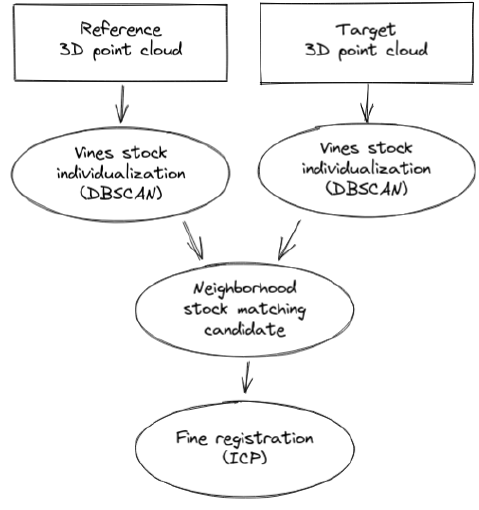
Figure 10: Details of the 3D non rigid registration method. The data from the same row of vines were selected from both the reference and the target datasets, then processed separately to re- construct each vine in 3D (Figure 12-Top): 201957 points and 16 clusters have been extracted from the target dataset, respectively 183401 points and 18 clusters from the reference dataset (Fig- ure 12-Center). This difference in the number of stocks detected has two explanations: one of the two acquisitions covers a slightly larger area, and with the leaves some vines can be grouped by two, without impacting the results presented below. Thus, a fine and precise 3D reconstruction of the vines has been produced. After the matching step, 16 individual rigid transformations have been computed (one for each vine stock extracted in the target dataset), all with inliers RMSE smaller than 1cm (Figure 11). Details of vine stocks after registration can be seen in Figure 8- Bottom.